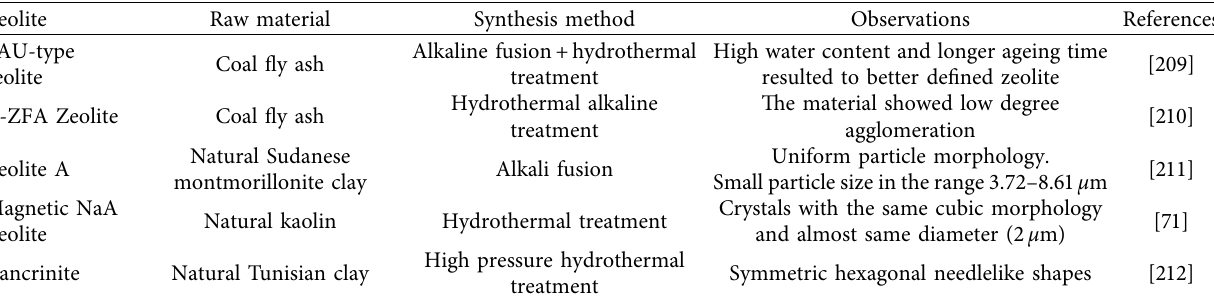
Table 4: Summary of SEM analysis of